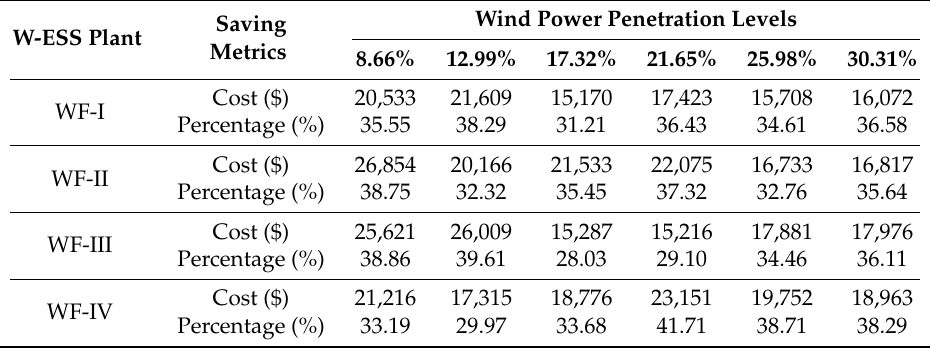
Figure 8. Power output of the ESS. Table 5. Saving costs and percentages using the ESS in the WTESS with six wind power penetration levels on four W-ESS